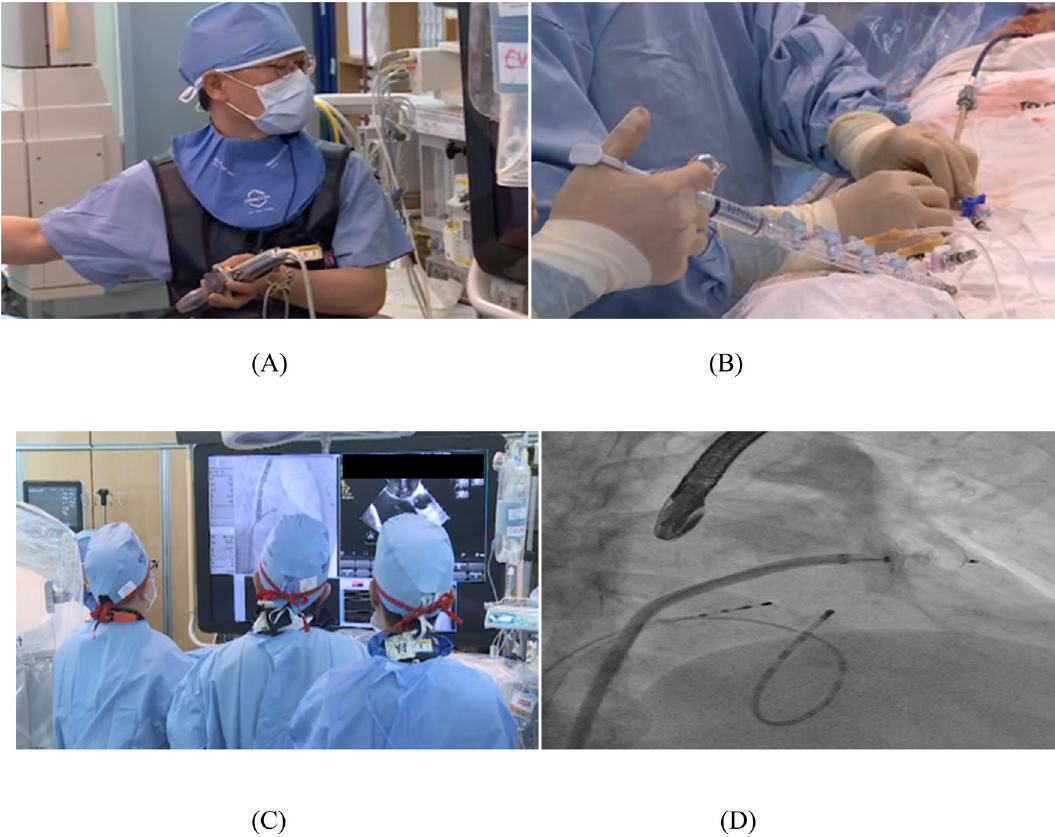
Figure 7. LAAO was performed using a device of the predicted size. ( A ) A cardiologist performing TEE during the procedure. ( B ) Another cardiologist injecting saline, medicine, and medium contrast through the manifold. ( C ) Checking of fluoroscopy and TEE in real time during the procedure. ( D ) Confirmation of the device insertion predicted by fluoroscopy correctly into the LAA. LAA left atrial appendage, LAAO left atrial appendage occlusion, TEE transesophageal